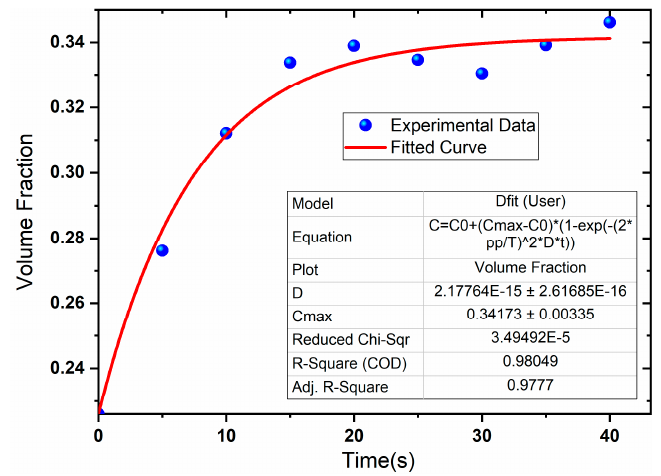
Figure 7. Fitting result of spatiotemporal concentration of ZnS nanoparticles.